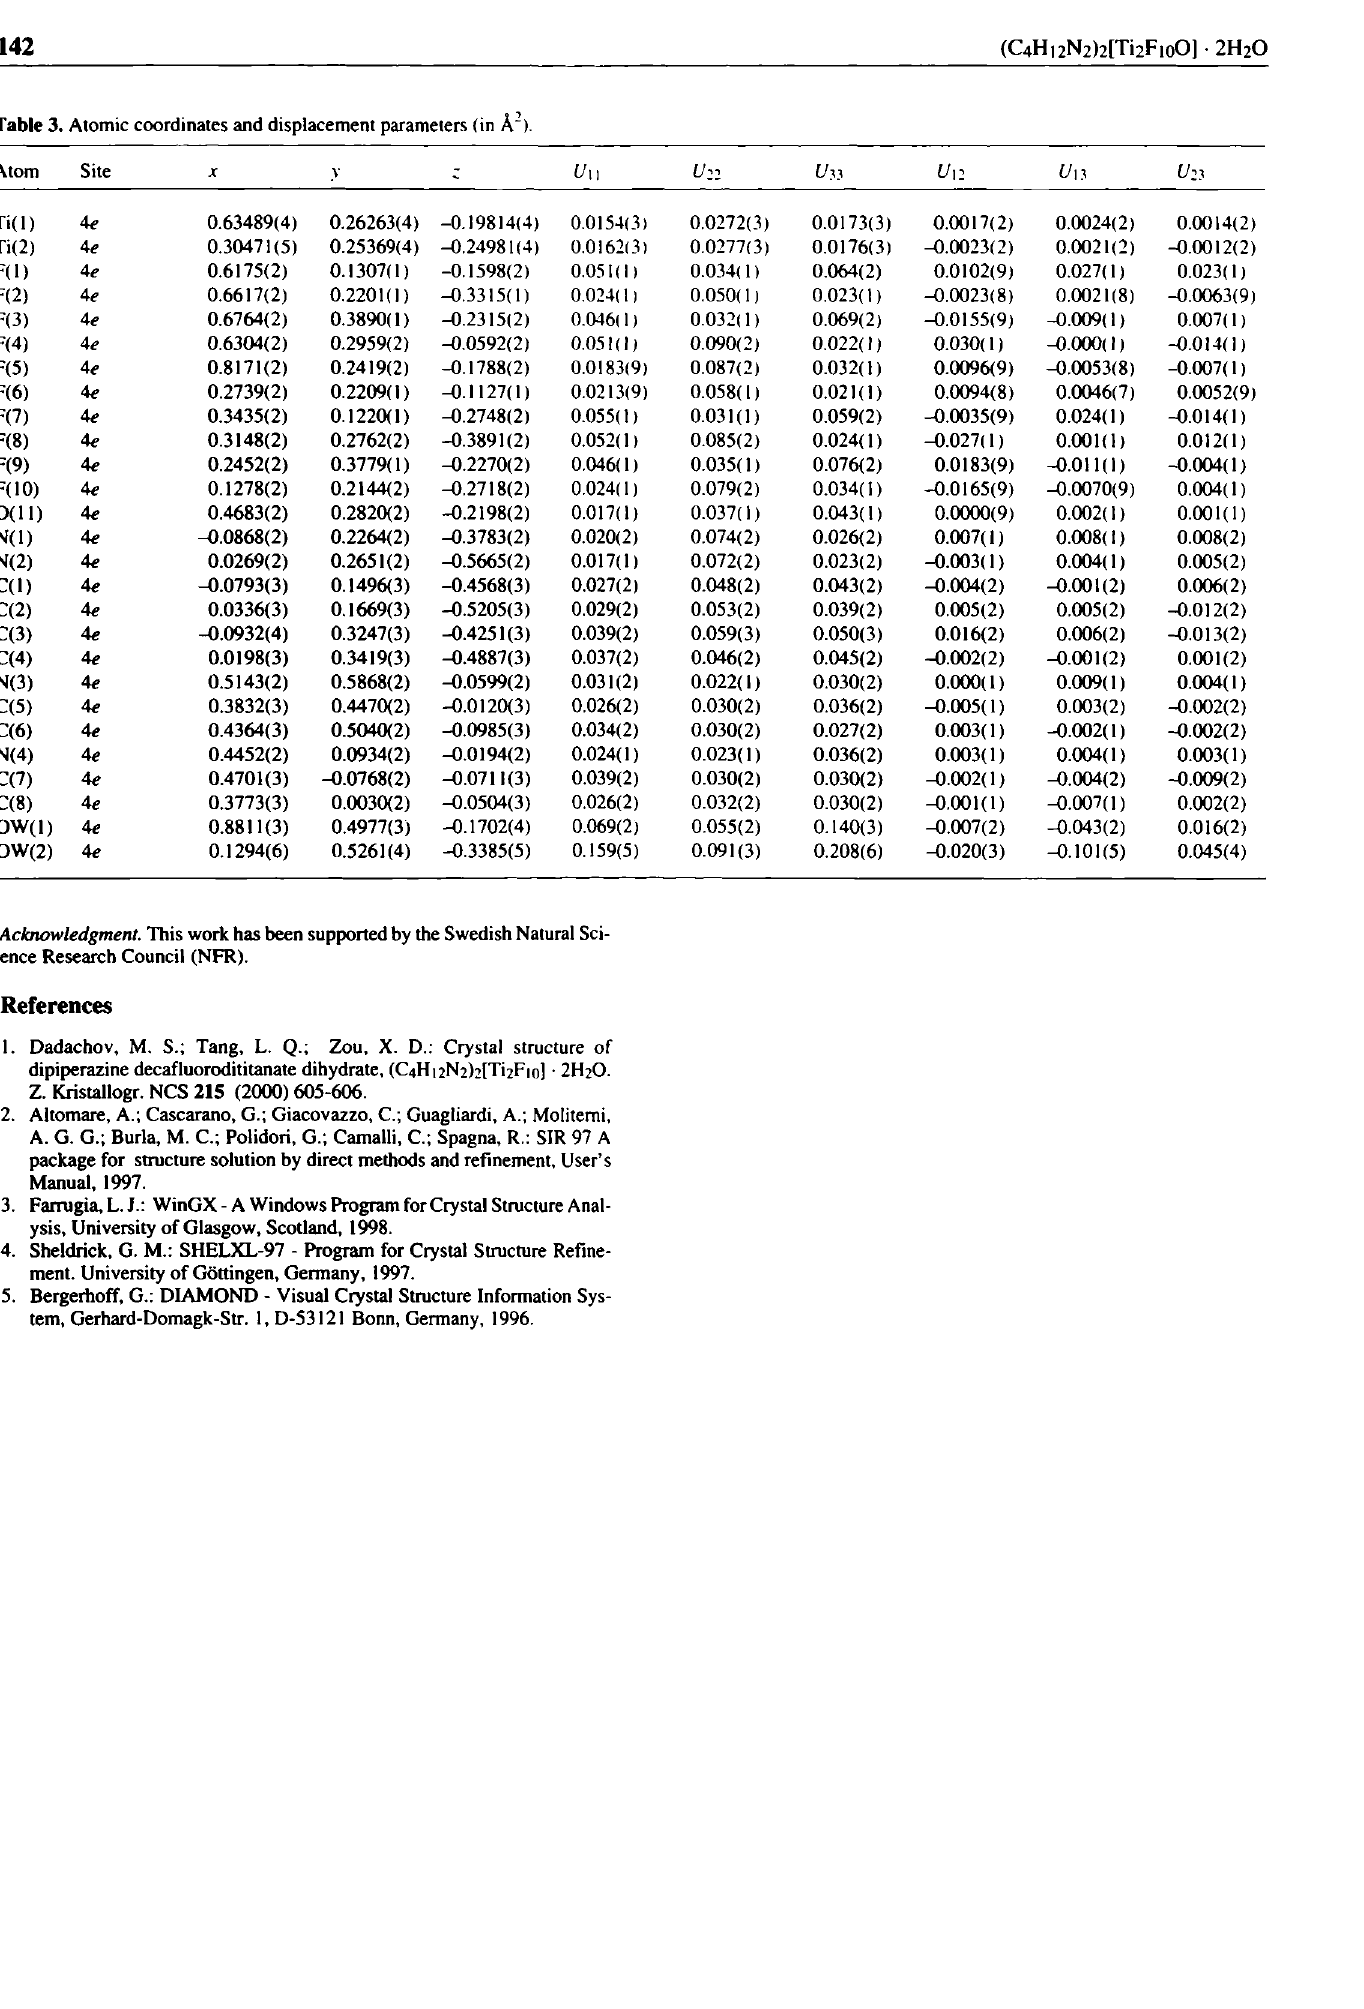
Table 3. Atomic coordinates and displacement parameters (in A 2